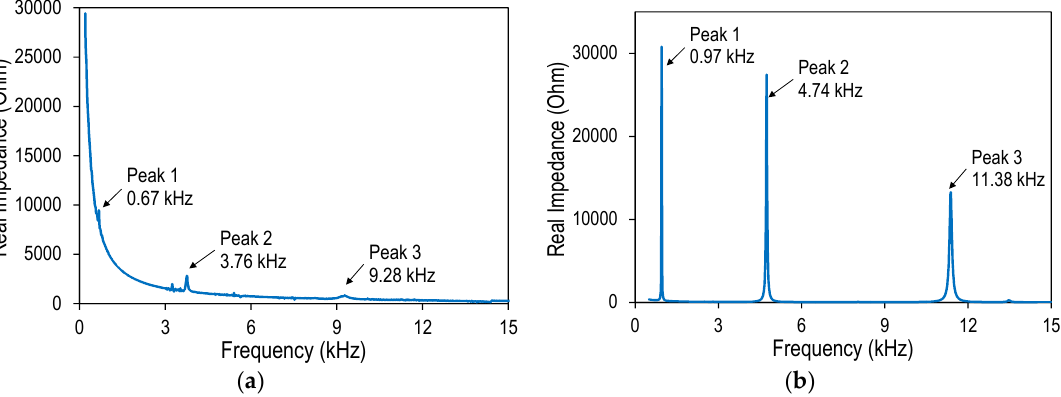
Figure 15. Experimental impedance signatures of wearable PZT interface under cable force F1: ( a ) experiment; ( b )